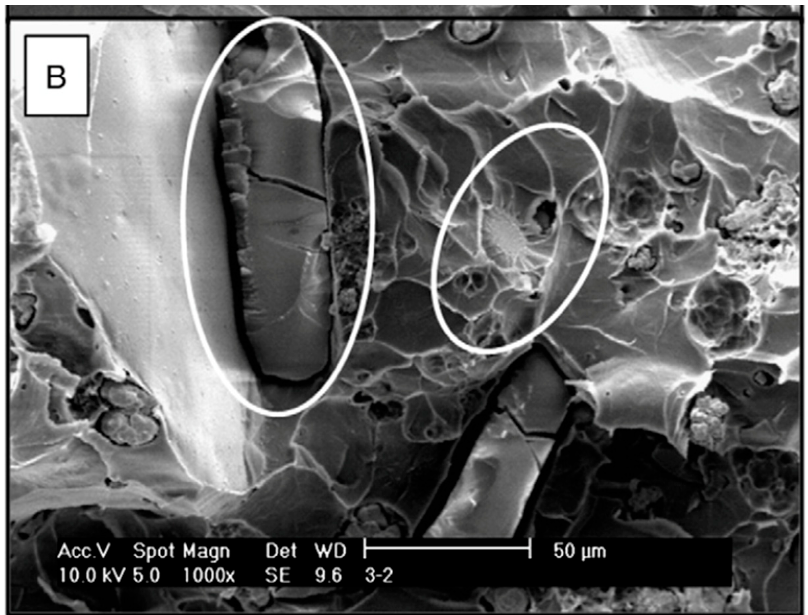
Figure 1. SEM micrograph of the fracture surface of a PMMA with vancomycin (1000 × ). The circles indicate the crystals. Taken from Paz et al. [4]; reprinted with permission from Elsevier .